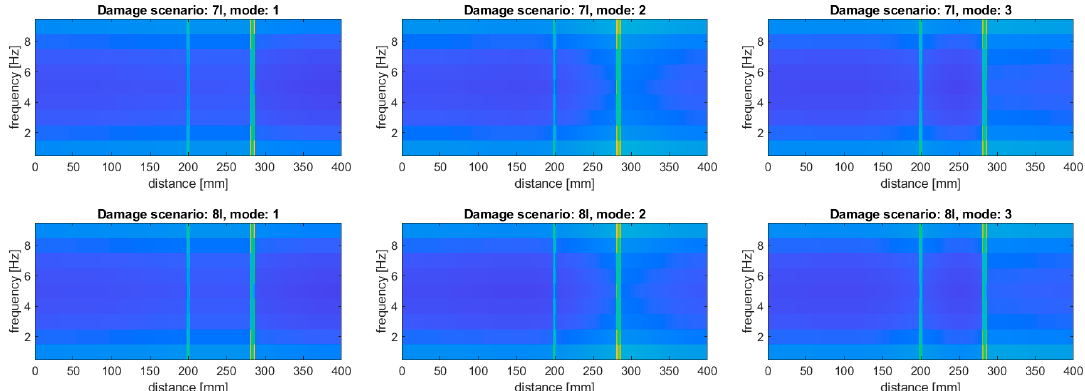
Figure 7. The results of the damage identification for the considered damage scenarios using baseline approach based on subtraction of the transformed mode shapes.